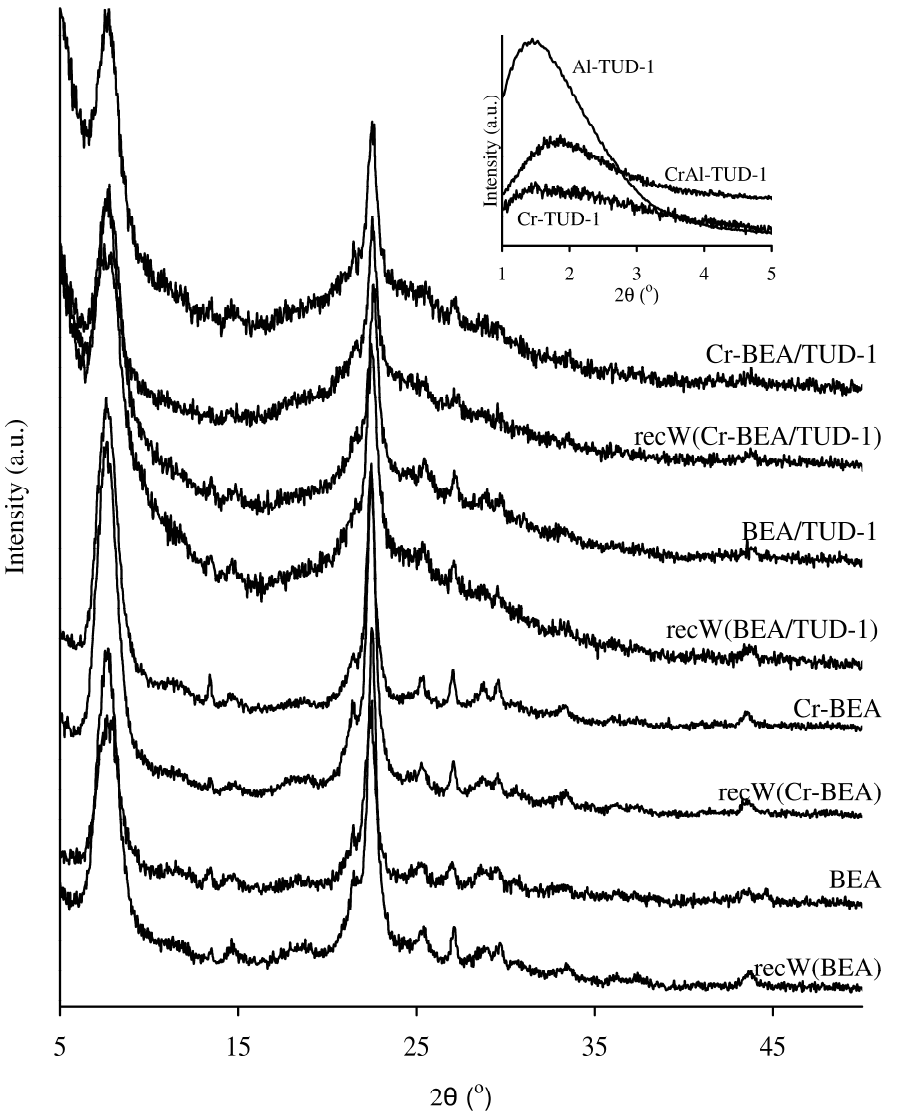
respective recW solids. The inset shows the low angle powder XRD patterns of the remaining materials